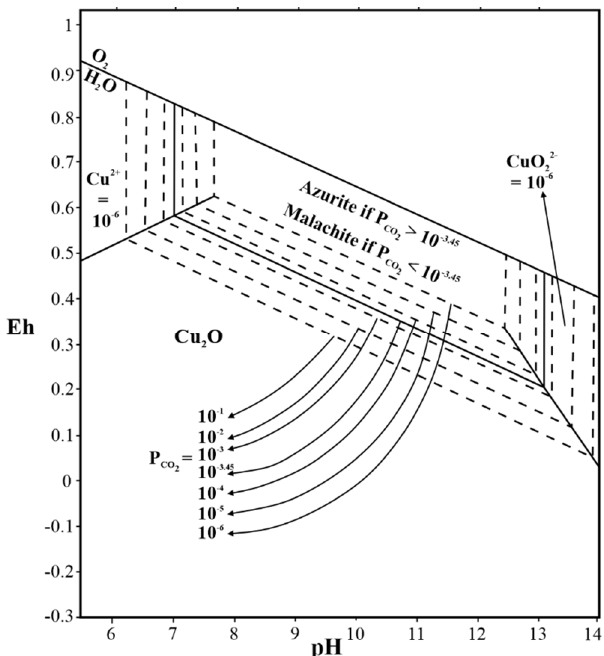
Figure 10. Eh-pH diagram of the system Cu-O-H-CO 2 at 25 °C and 1 atm. total pressure. Total dissolved copper 10 − 6 mol. The diagram shows the stability fields of malachite and azurite as a function of P CO2 . Equilibrium is reached at P CO2 = 10 − 3.45 atm. with corresponding pH = 6.95, pH = 13.05 and Eh = 0.67–0.0592pH (straight lines) (modified from reference [61]).